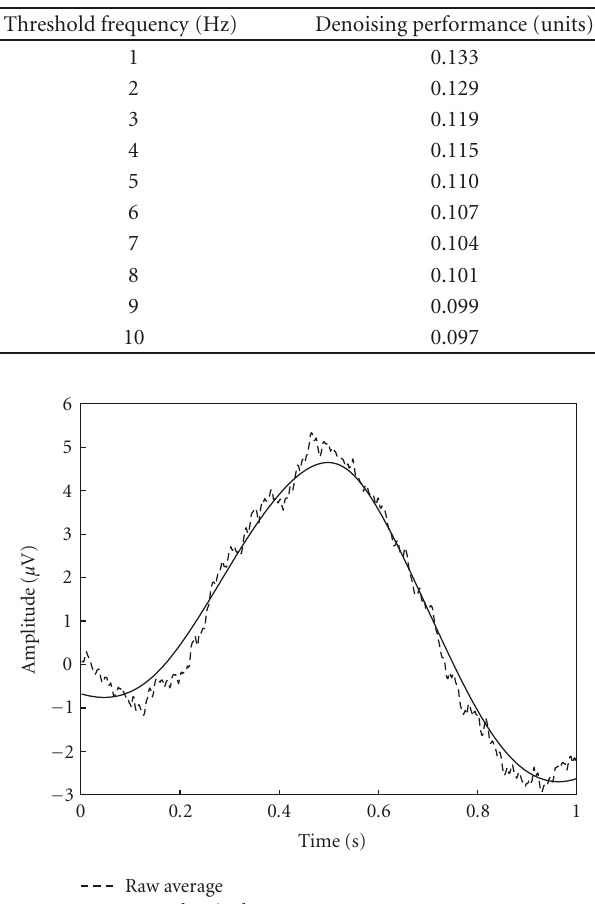
Table 1: Denoising performance as function of threshold fre- quency.